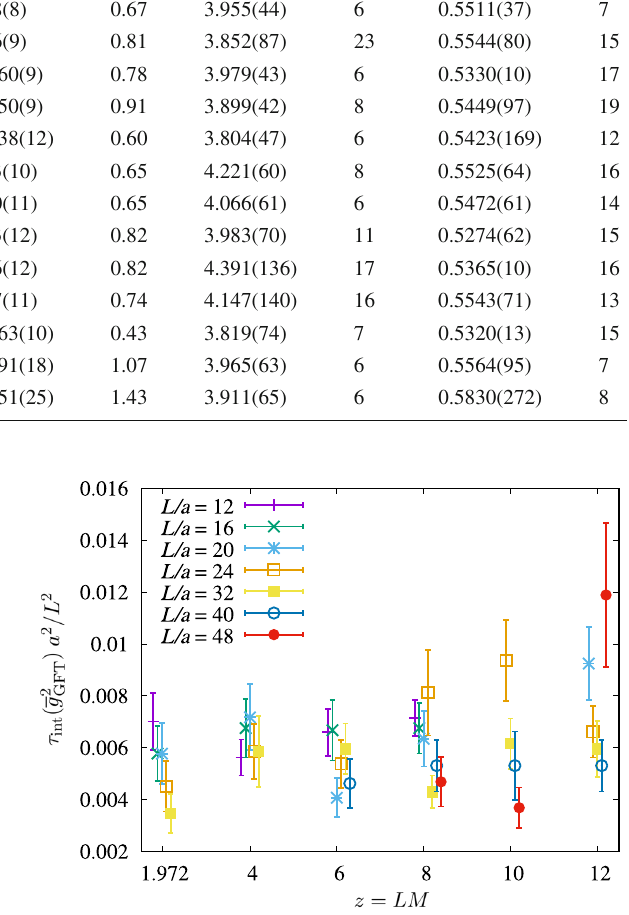
Fig. 7 Integrated autocorrelation times τ int ( g 2 coupling in units of measurements (every five trajectories, i.e., 10 MDUs) scaled with a 2 / L 2 vs. the dimensionless quantity z = LM of our massive simulations. The points are slightly shifted from actual z values for better visibility